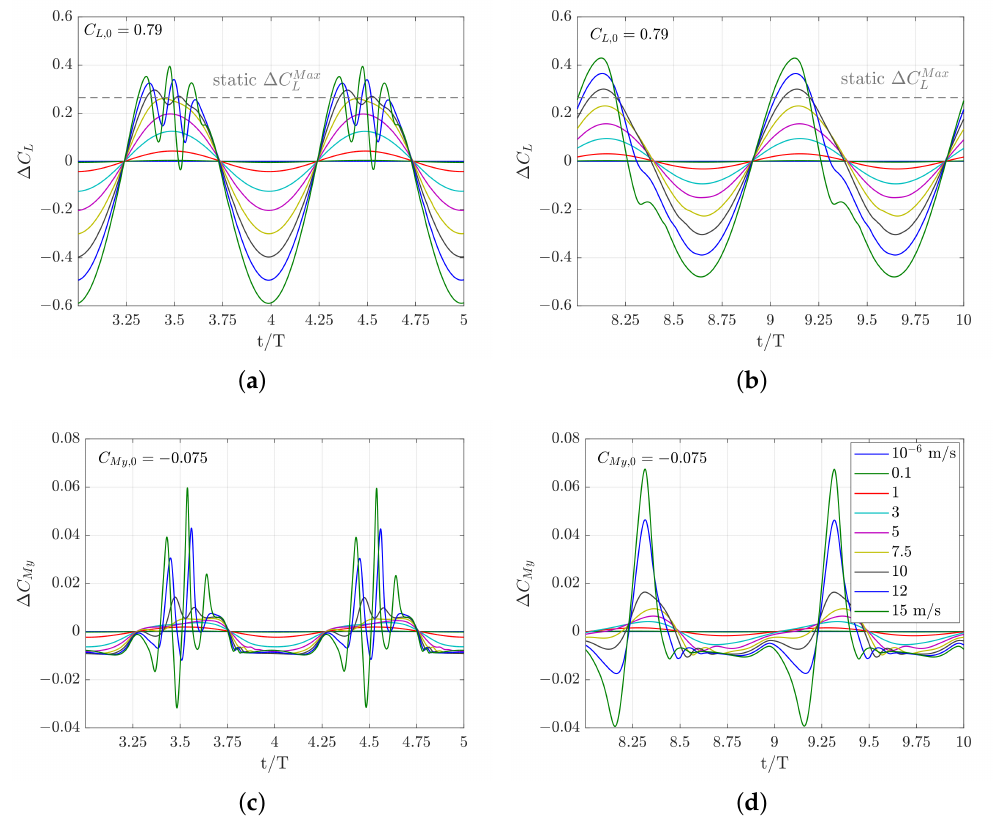
Figure 6. Global coefficients for two gust lengths and various amplitudes at Mach 0.70. ( a ) L G = 125.5 m (k = 0.05), ( b ) L G = 31.5 m (k = 0.20), ( c ) L G = 125.5 m (k = 0.05), ( d ) L G = 31.5 m (k =